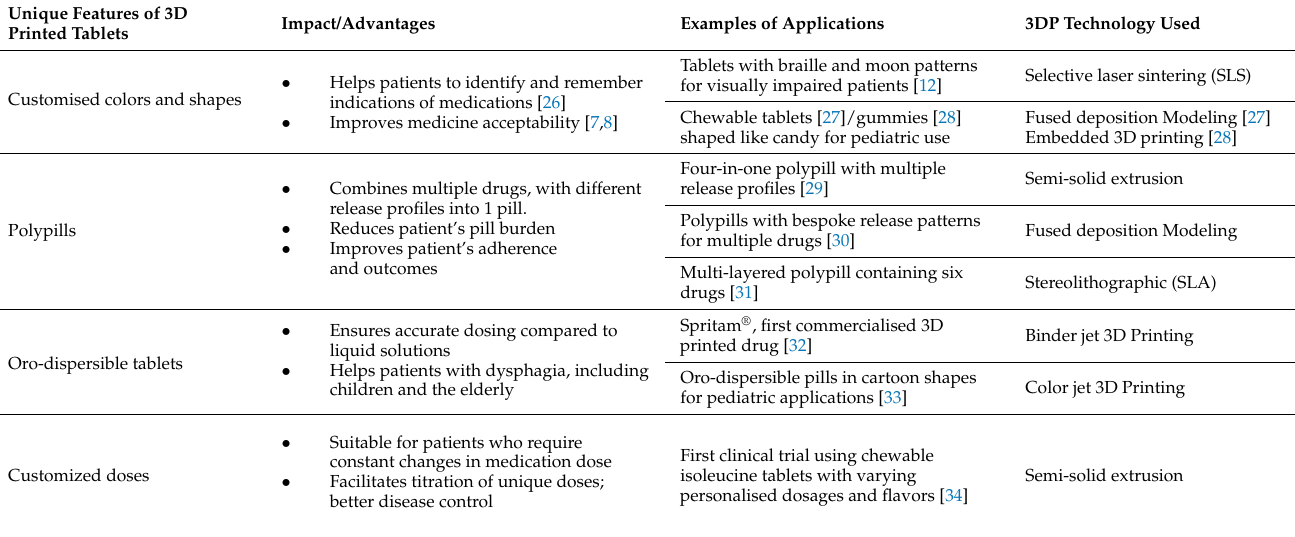
Table A1. Impact of 3D printing and current advances in